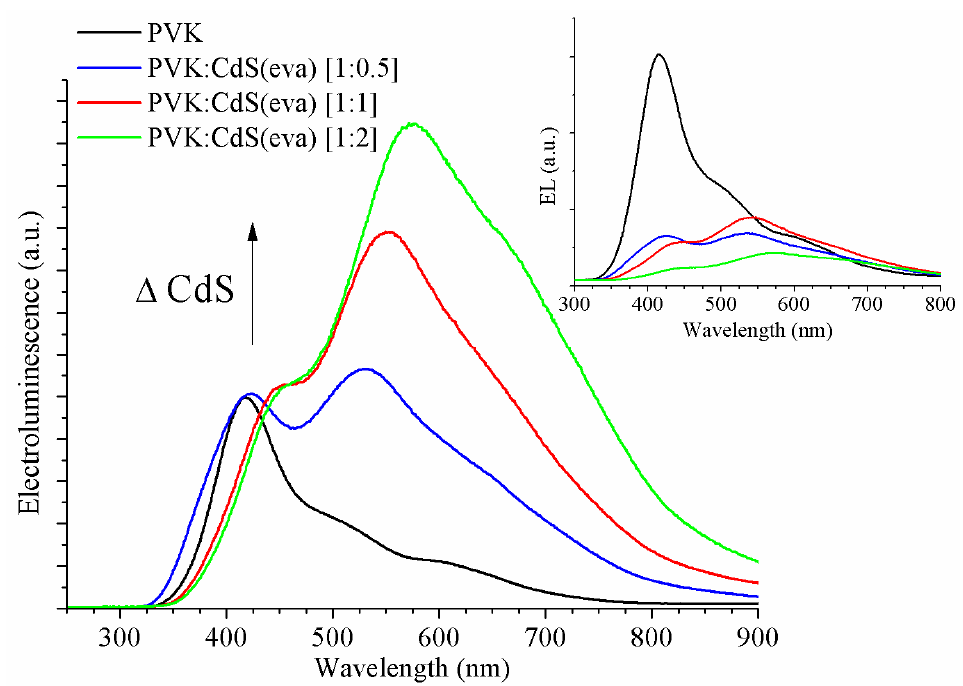
Figure 14. Normalized electroluminescence of the pristine PVK LED and hybrid LEDs using DMSO-free CdS NCs. PVK (black), PVK:CdS(eva) [1:0.5] (blue), [1:1] (red) and [1:2] (green). The inset shows as measured electroluminescence spectra for the same LEDs.